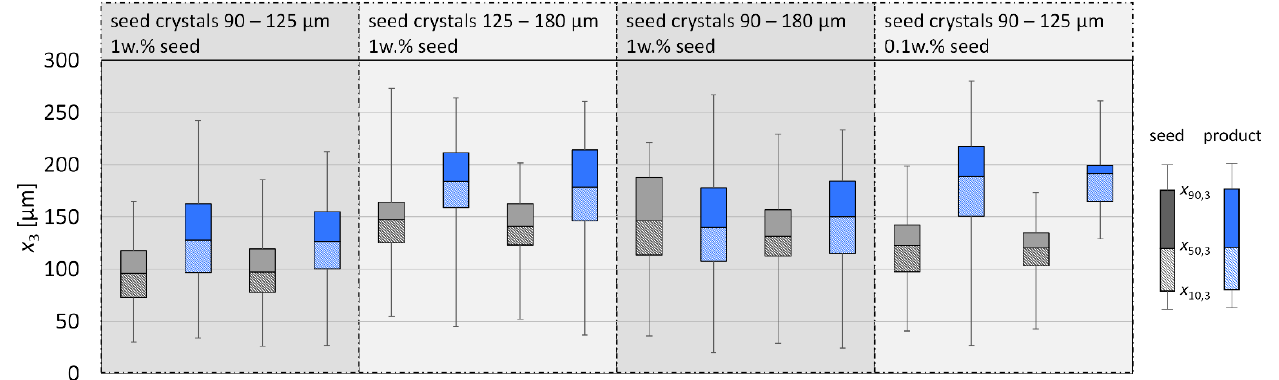
Figure 5. Crystal size distribution (via sedimentation method) shown as boxplots for crystal growth experiments with different seed crystal sizes and amounts; whiskers show minimum and maximum measured crystal.